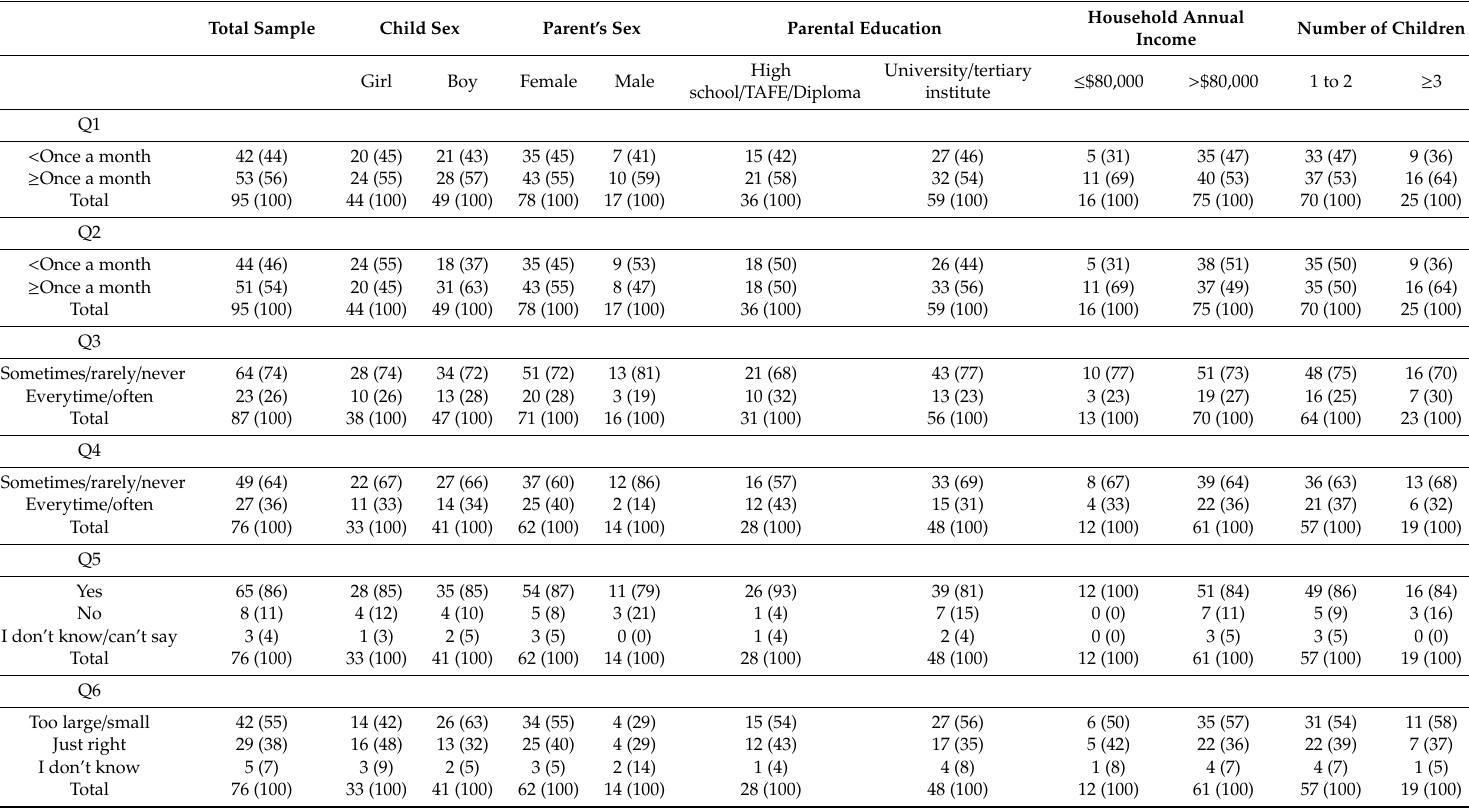
Table 3. Grouped survey responses, n (%), stratified by dichotomized sociodemographic